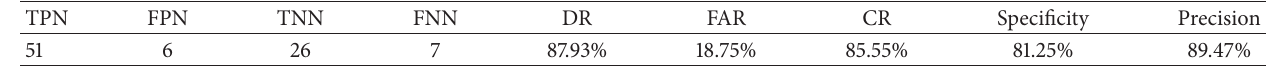
Table 5: Evaluation results of our proposed system in DR, FAR, and CR.